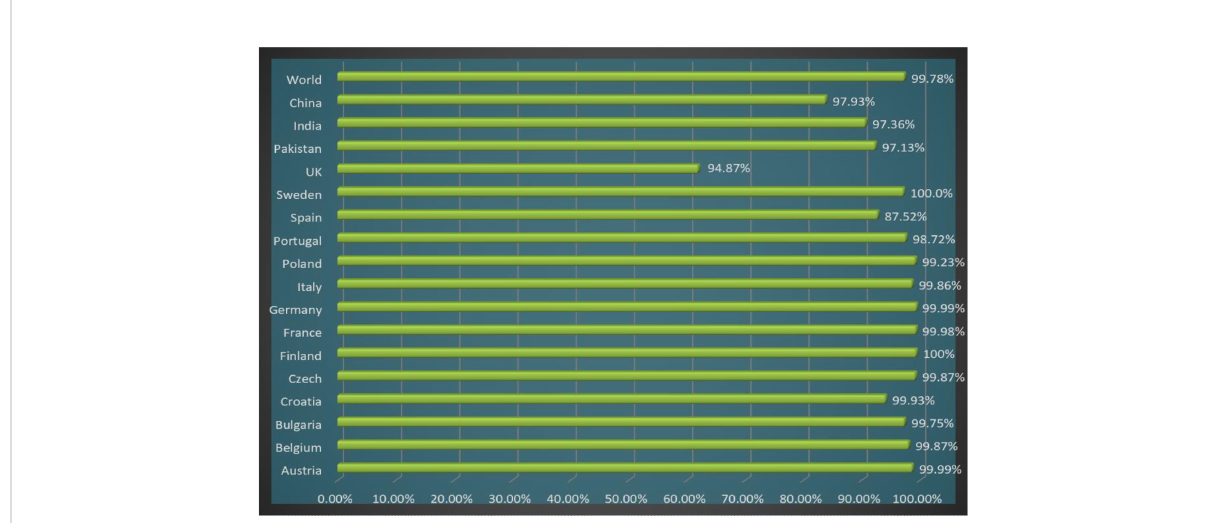
FIGURE 5 Chimeric vaccine population coverage analysis for the world and different